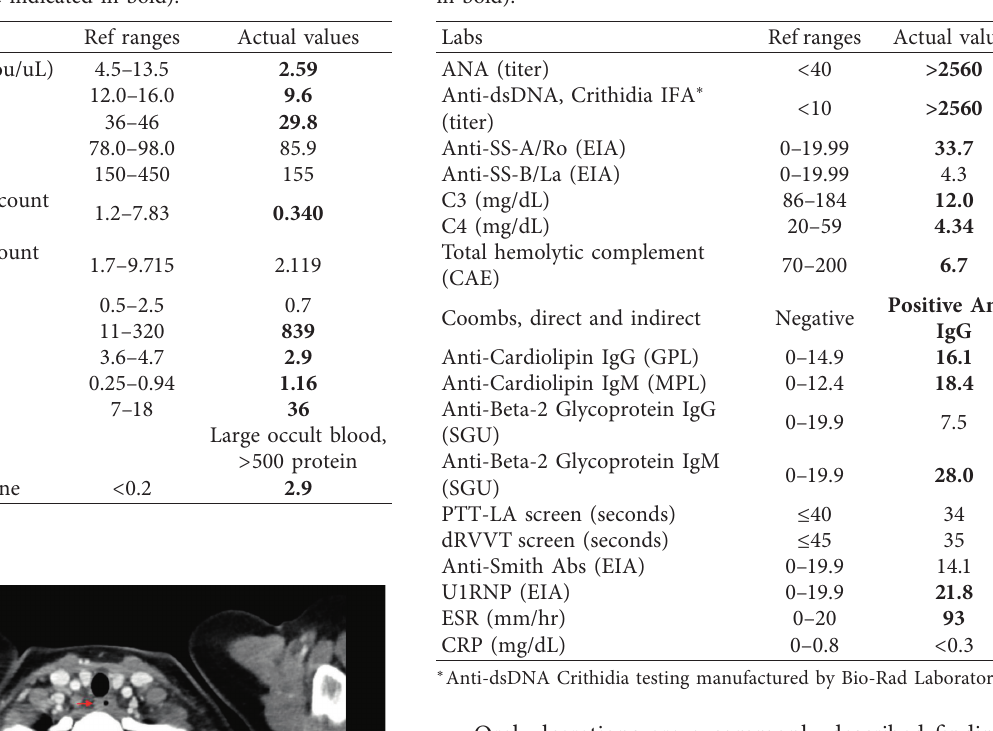
Table 1: Initial laboratory studies at the time of presentation (abnormal findings are indicated in bold).